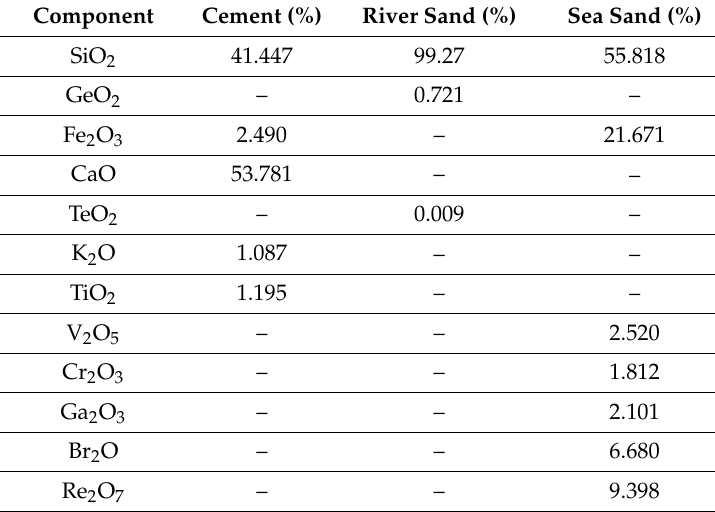
Table 1. Chemical composition of the cement, sand, and sea sand.